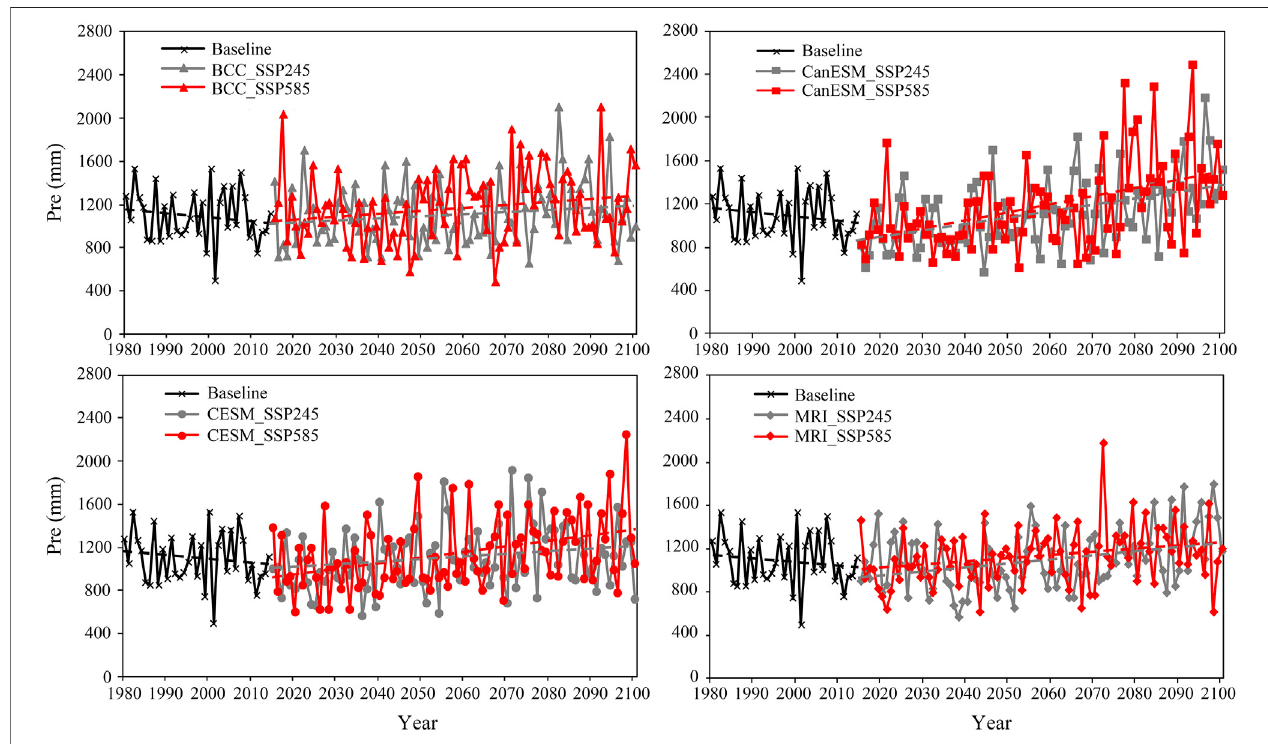
FIGURE 4 | Trend results of annual mean precipitation for each GCM in the Xixian basin from 1980 to 2100.